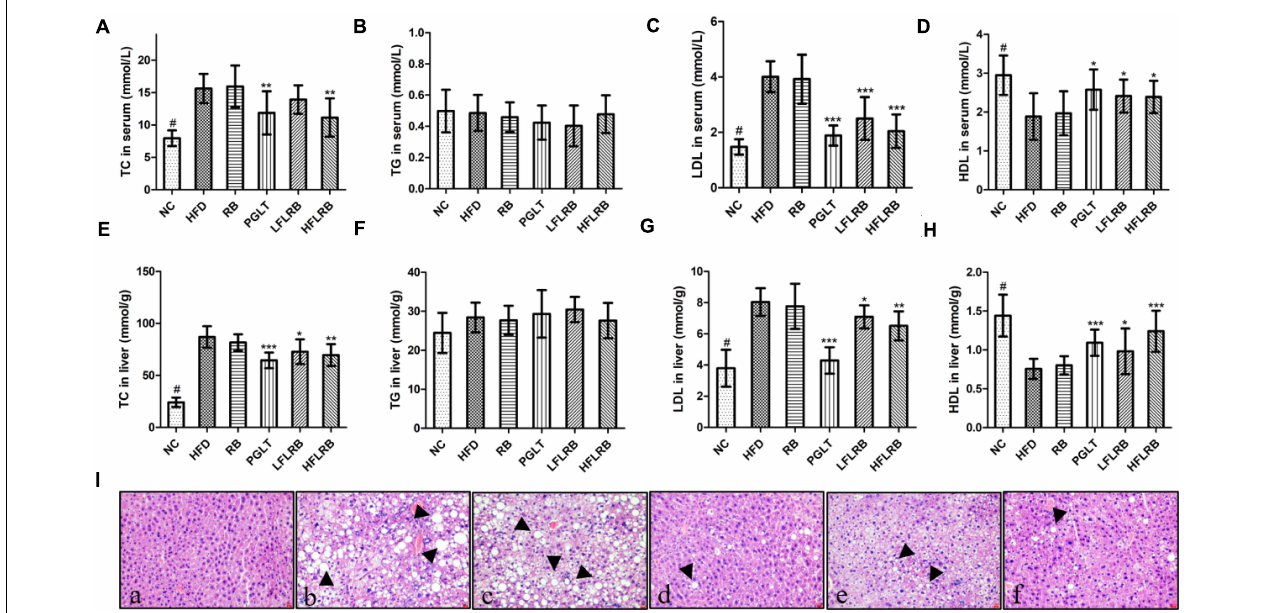
FIGURE 3 | Effects of FLRB on the lipid profile in mice. (A–H) Total cholesterol (TC), triglyceride (TG), low-density lipoprotein cholesterol (LDL), high-density lipoprotein cholesterol (HDL) levels in serum and liver; (I) hematoxylin and eosin (H&E) staining of liver tissue. (a) : negative group (NC), (b) : HFD, (c) : RB, (d) : PGLT, (e) : LFLRB, (f) : HFLRB. Representative results are shown. Scale bar: 2 µ m. Values are expressed as the mean ± SD ( n = 10). # and *** represent P < 0.001, ** represents P < 0.01, * represents P < 0.05, compared to the HFD.